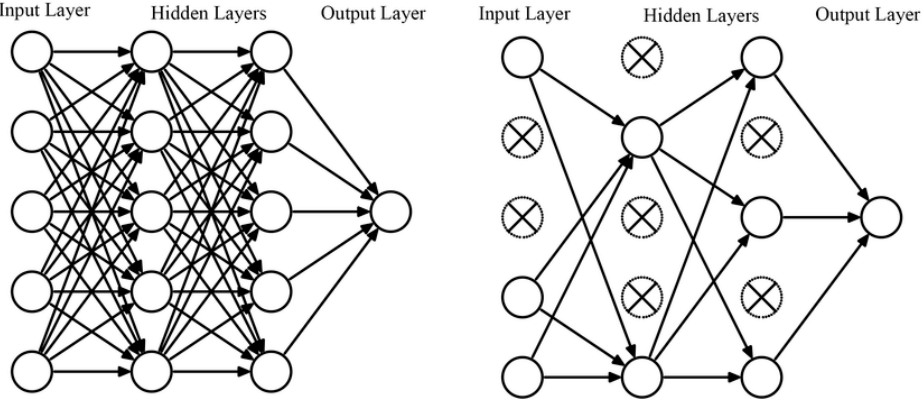
Figure 5. Process illustration in dropout layer [41].